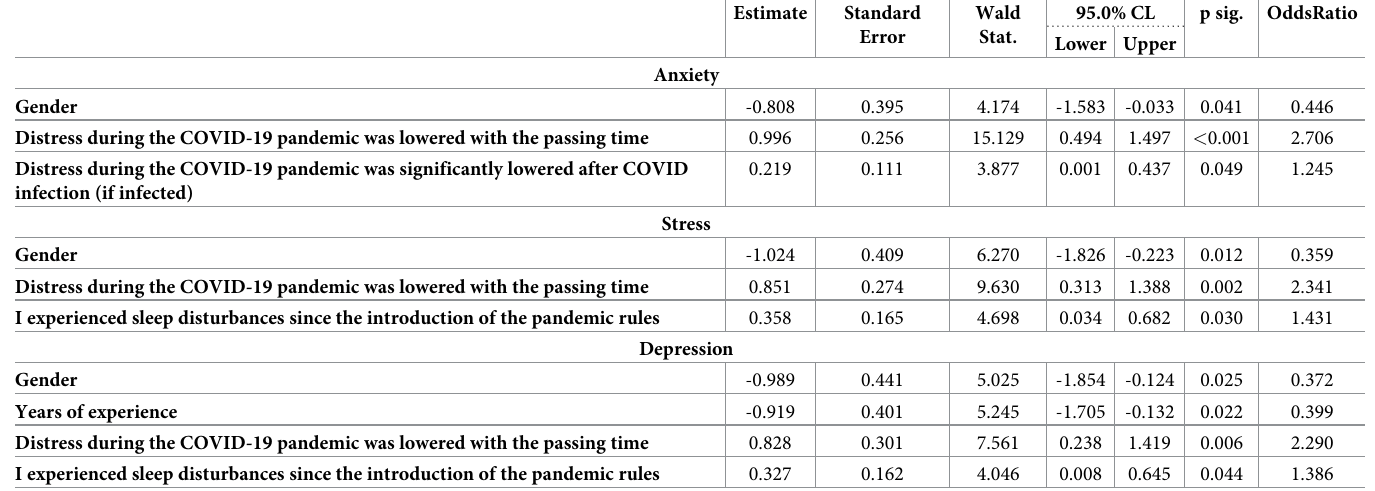
Table 6. Multivariate models for improved levels of anxiety, stress, and